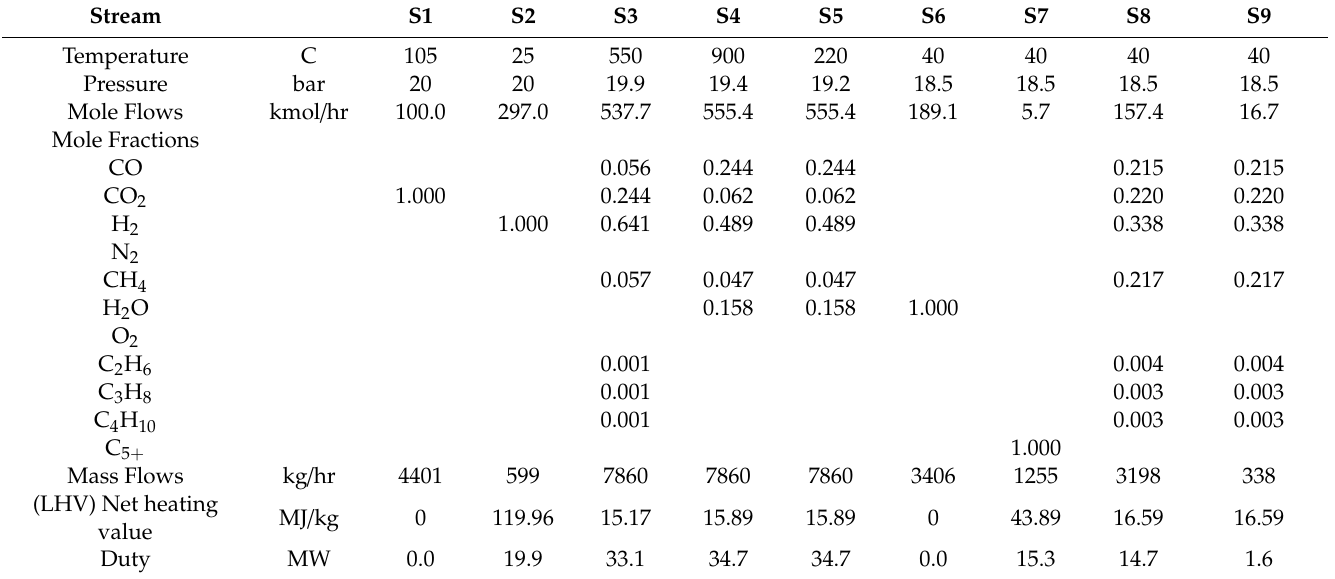
Table A6. Simulated stream results for